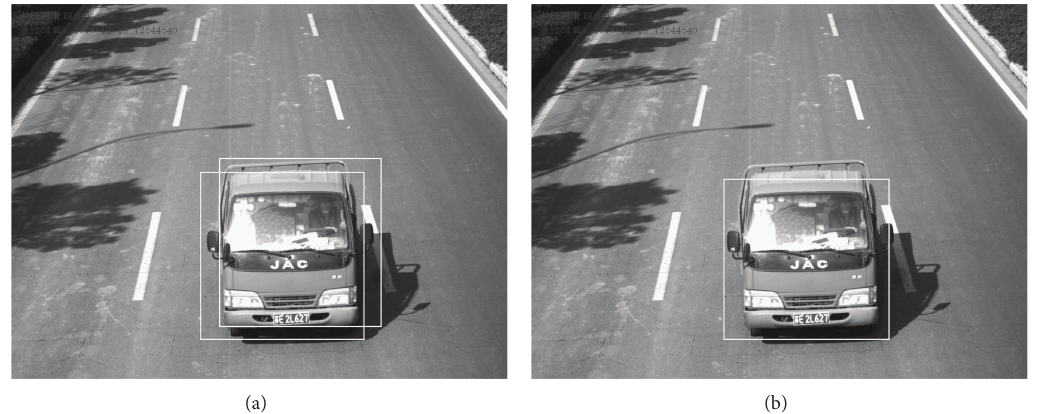
Figure 8: The intersection relations for the bounding boxes and the averaged